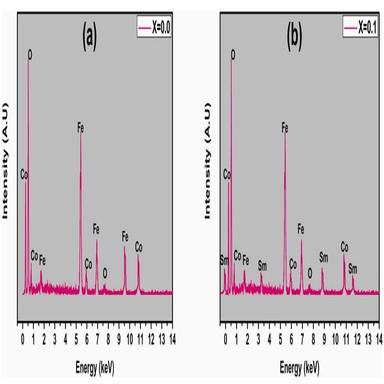
EDS spectra of CoFe2-xSmxO4 (a) x = 0.0 (b) x = 0.1 ferrites.